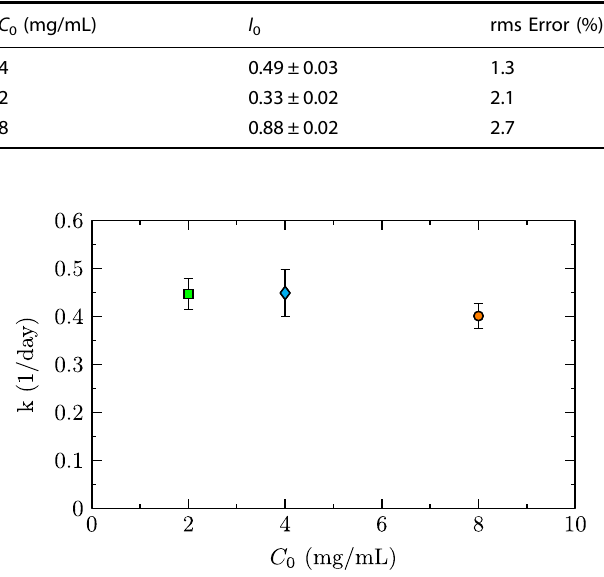
Fig. 3 Intrinsic fi brillization rate k versus protein concentration C 0 . Values of k were determined by (Eq. 1). Error bars represent fi t